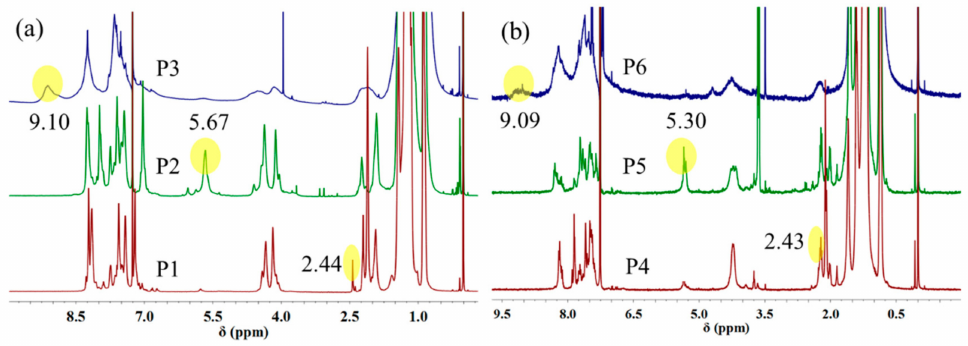
Figure 2. NMR spectra of polymers recorded in CDCl 3 .